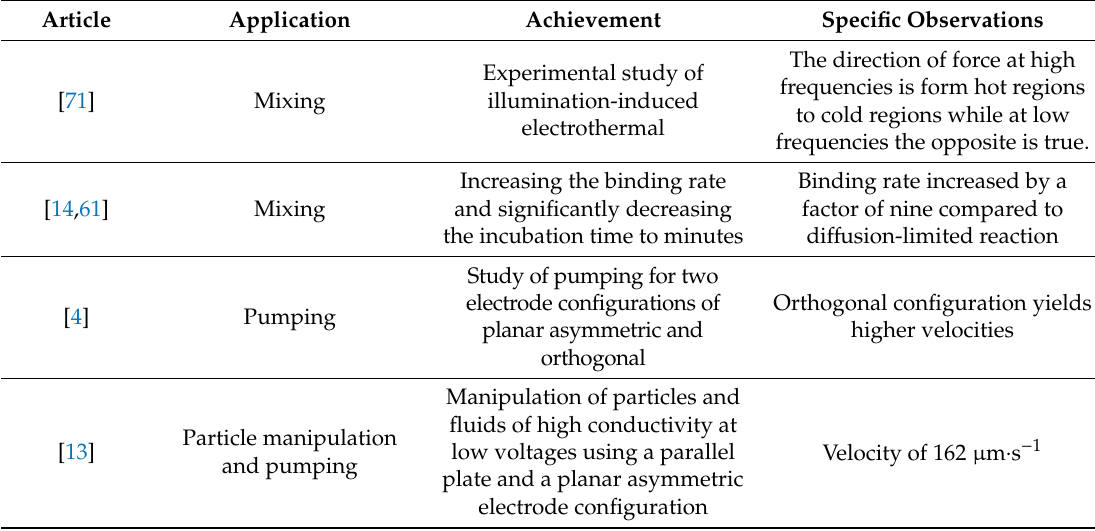
Table A1. A short summary of relevant articles studying the electrothermal e ff ect, useful for new researchers in this field as a guide to what has been done and those who are working in the